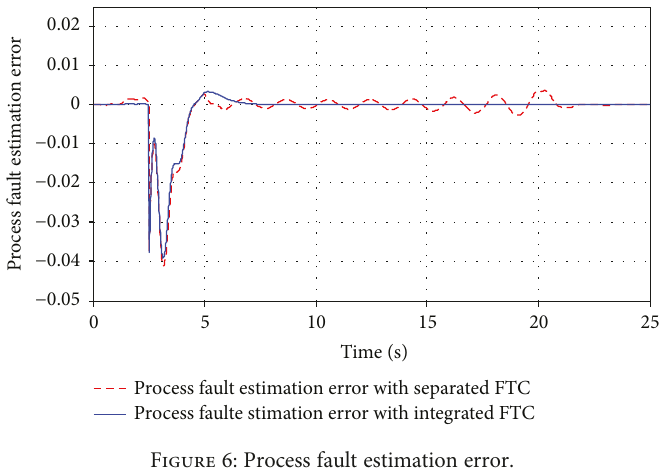
Figure 6: Process fault estimation error.